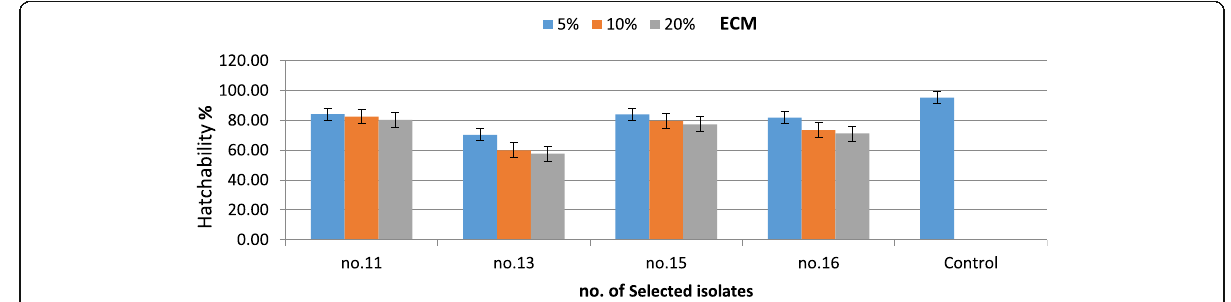
Fig. 3 Effect of different concentrations of ECM from the 4 selected isolates on hatchability percentage (%; M ± SE), and statistical treatments were performed using ANOVA for differences comparing means in each concentration separately using Tukey ’ s HSD test. ANOVA parameters of 5, 10, and 20% concentrations, respectively were LSD = 1.628, 1.711, 1.509; P <